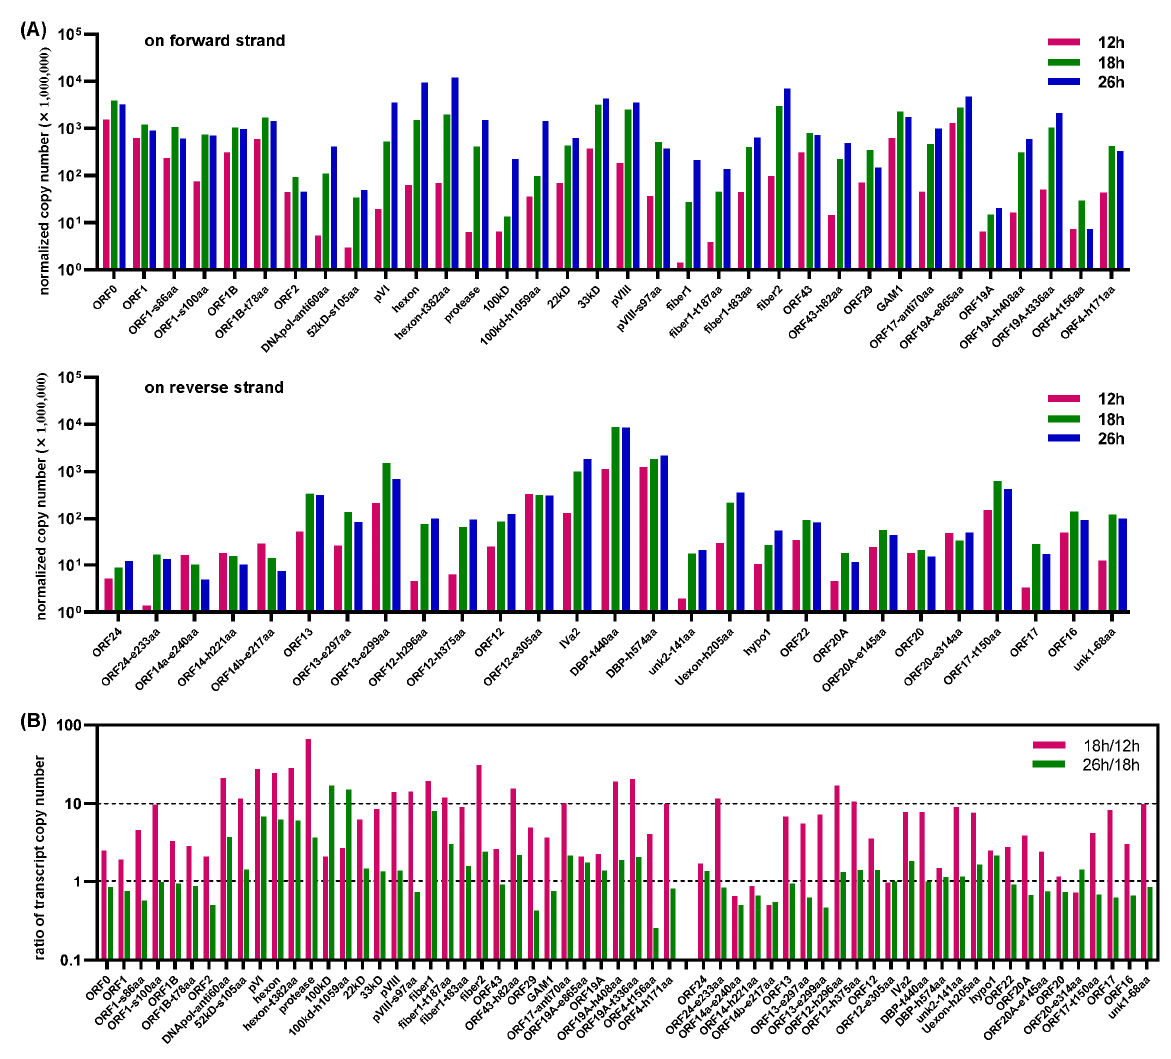
Figure 11. Transcription of FAdV-4 ORFs in LMH cells at 12, 18 and 26 h post virus infection. Virus ORFs with the combined copy number greater than 100 were selected for transcript abundance analysis at different time points post infection. The copy number of each selected viral ORF was normalized by that of total detected transcripts (including those from cells and from viruses, Table S1) at every time points. ( A ) Transcription of viral ORFs on the forward or the reverse strands at 12, 18 and 26 h post virus infection. ( B ) Change of the transcription intensity for viral ORFs during virus replication.